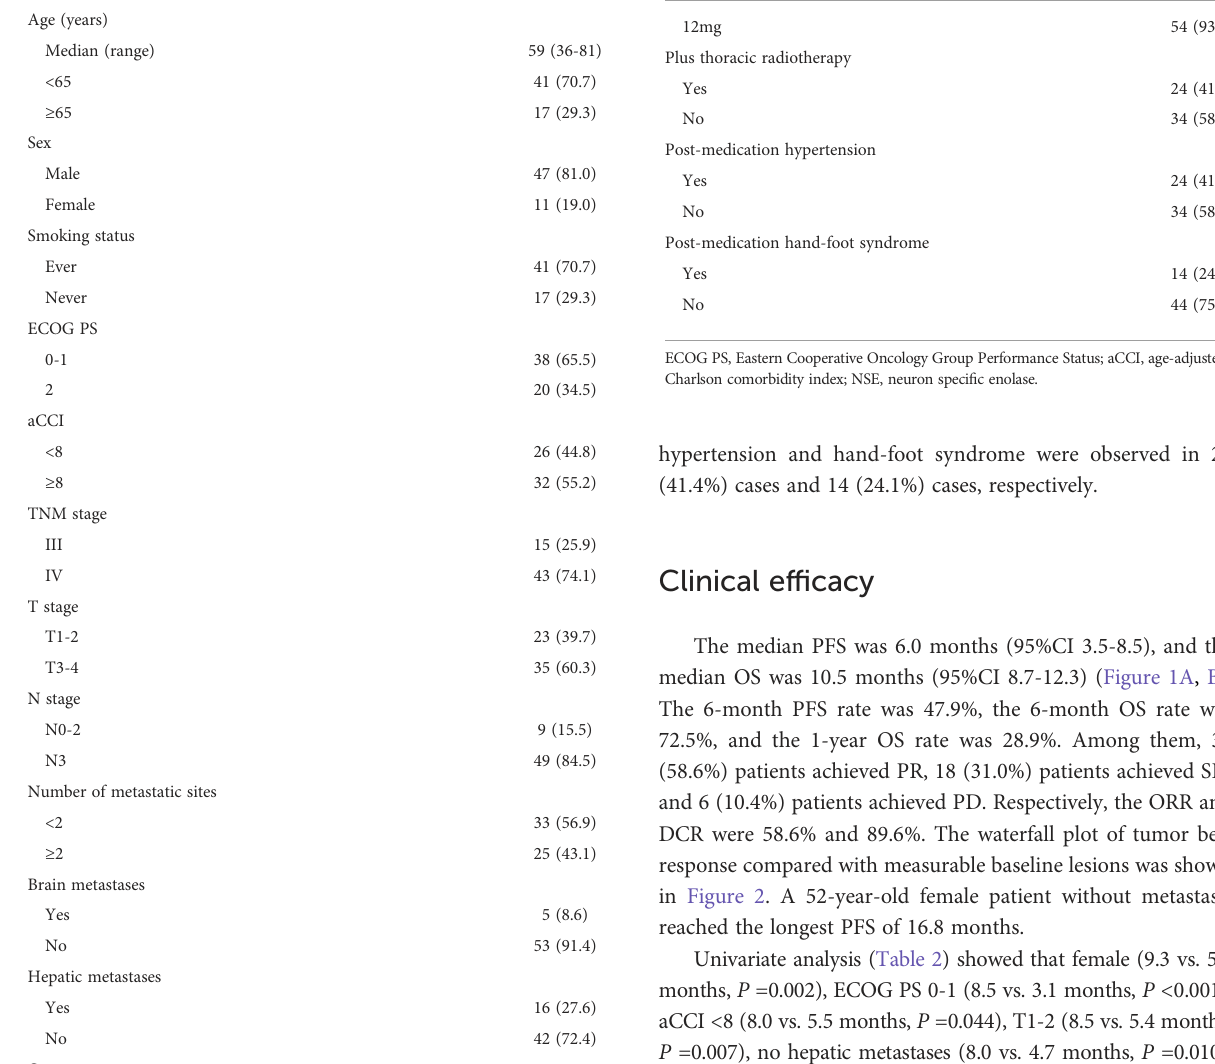
and 6 (10.4%) patients achieved PD. Respectively, the ORR and DCR were 58.6% and 89.6%. The waterfall plot of tumor best response compared with measurable baseline lesions was shown in Figure 2. A 52-year-old female patient without metastasis reached the longest PFS of 16.8 months. Univariate analysis (Table 2) showed that female (9.3 vs. 5.5